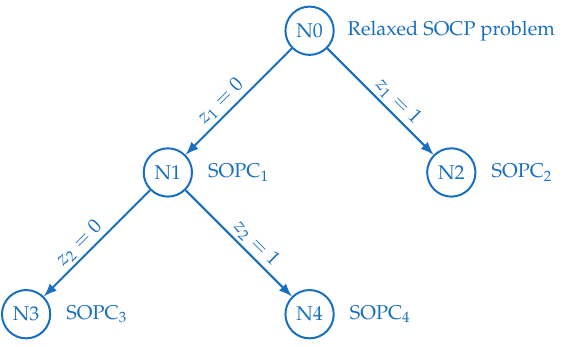
Figure 4. Schematic representation of the B&B method for addressing MI-SOCP problems.